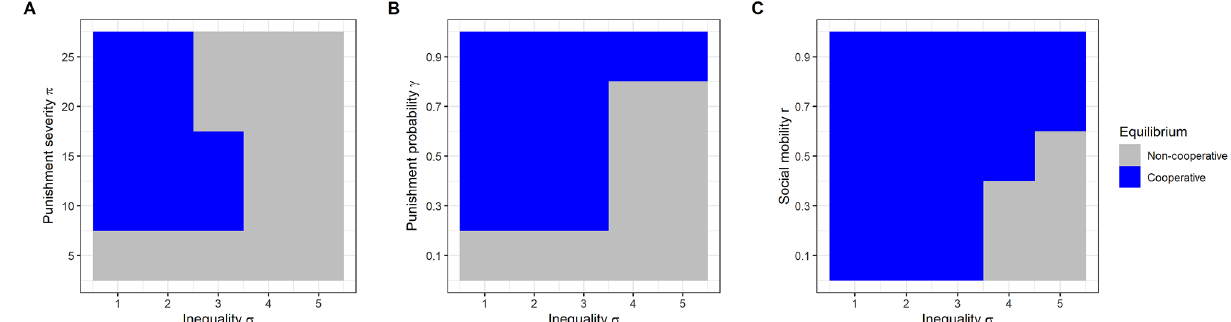
Figure 3. Equilibrium population states by starting parameters. ( A ) Varying the initial inequality in resources σ and the severity of punishment π, whilst holding constant the probability of punishment γ at 1/3 and social mobility r at 0.1. ( B ) Varying the initial inequality in resources σ and the probability of punishment γ whilst holding the severity of punishment constant at π = 10 and social mobility r at 0.1. ( C ) Varying the initial inequality in resources σ and the level of social mobility r whilst holding constant the probability of punishment γ at 1/3 and the severity of punishment π at